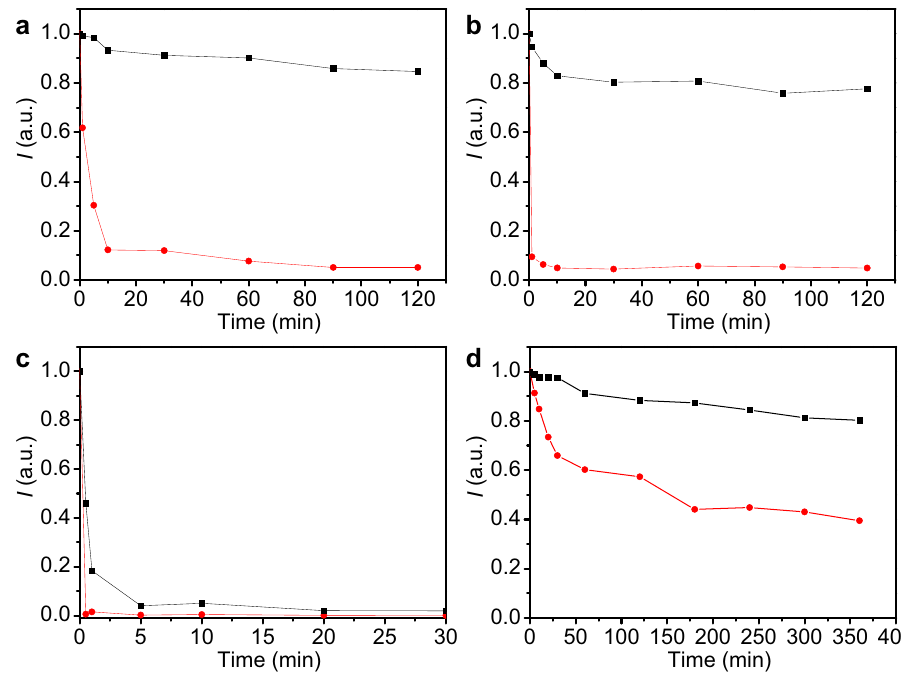
Fig. 5 Stability analysis of CsPbBr 3 – NaYF 4 :Yb,Tm hybrid nanocrystals. PL intensity test was used to monitor the stabilities of CsPbBr 3 (red) and the heterostructure composite of CsPbBr 3 – NaYF 4 :Yb,Tm nanocrystals (black) in cyclohexane and ethanol (v/v = 9: 1) mixed solvent ( a ), cyclohexane and ethanol (v/v = 1: 1) mixed solvent ( b ), water solvent ( c ), and continuous ultraviolet light irradiation ( d ) under 365 nm